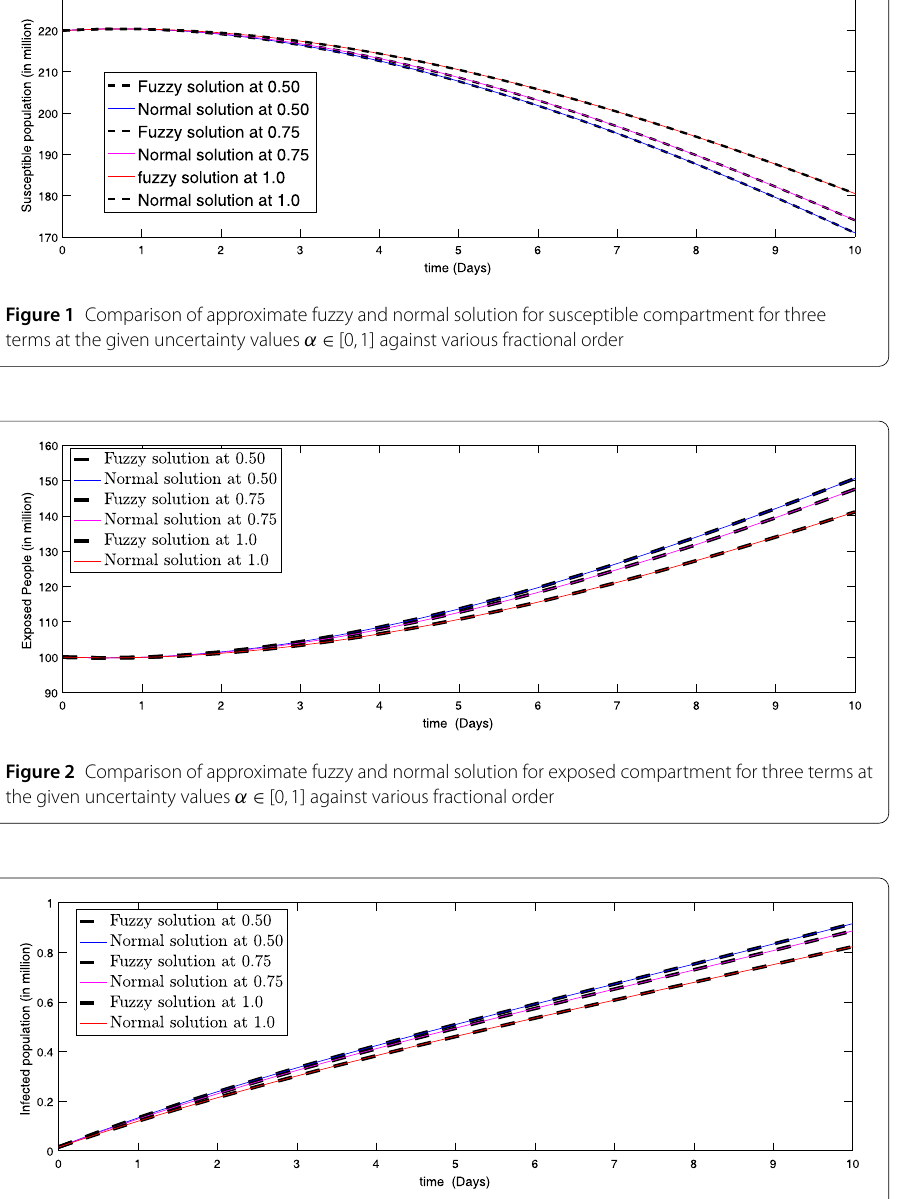
Figure 3 Comparison of approximate fuzzy and normal solution for infected compartment for three terms at the given uncertainty values α ∈ [0,1] against various fractional